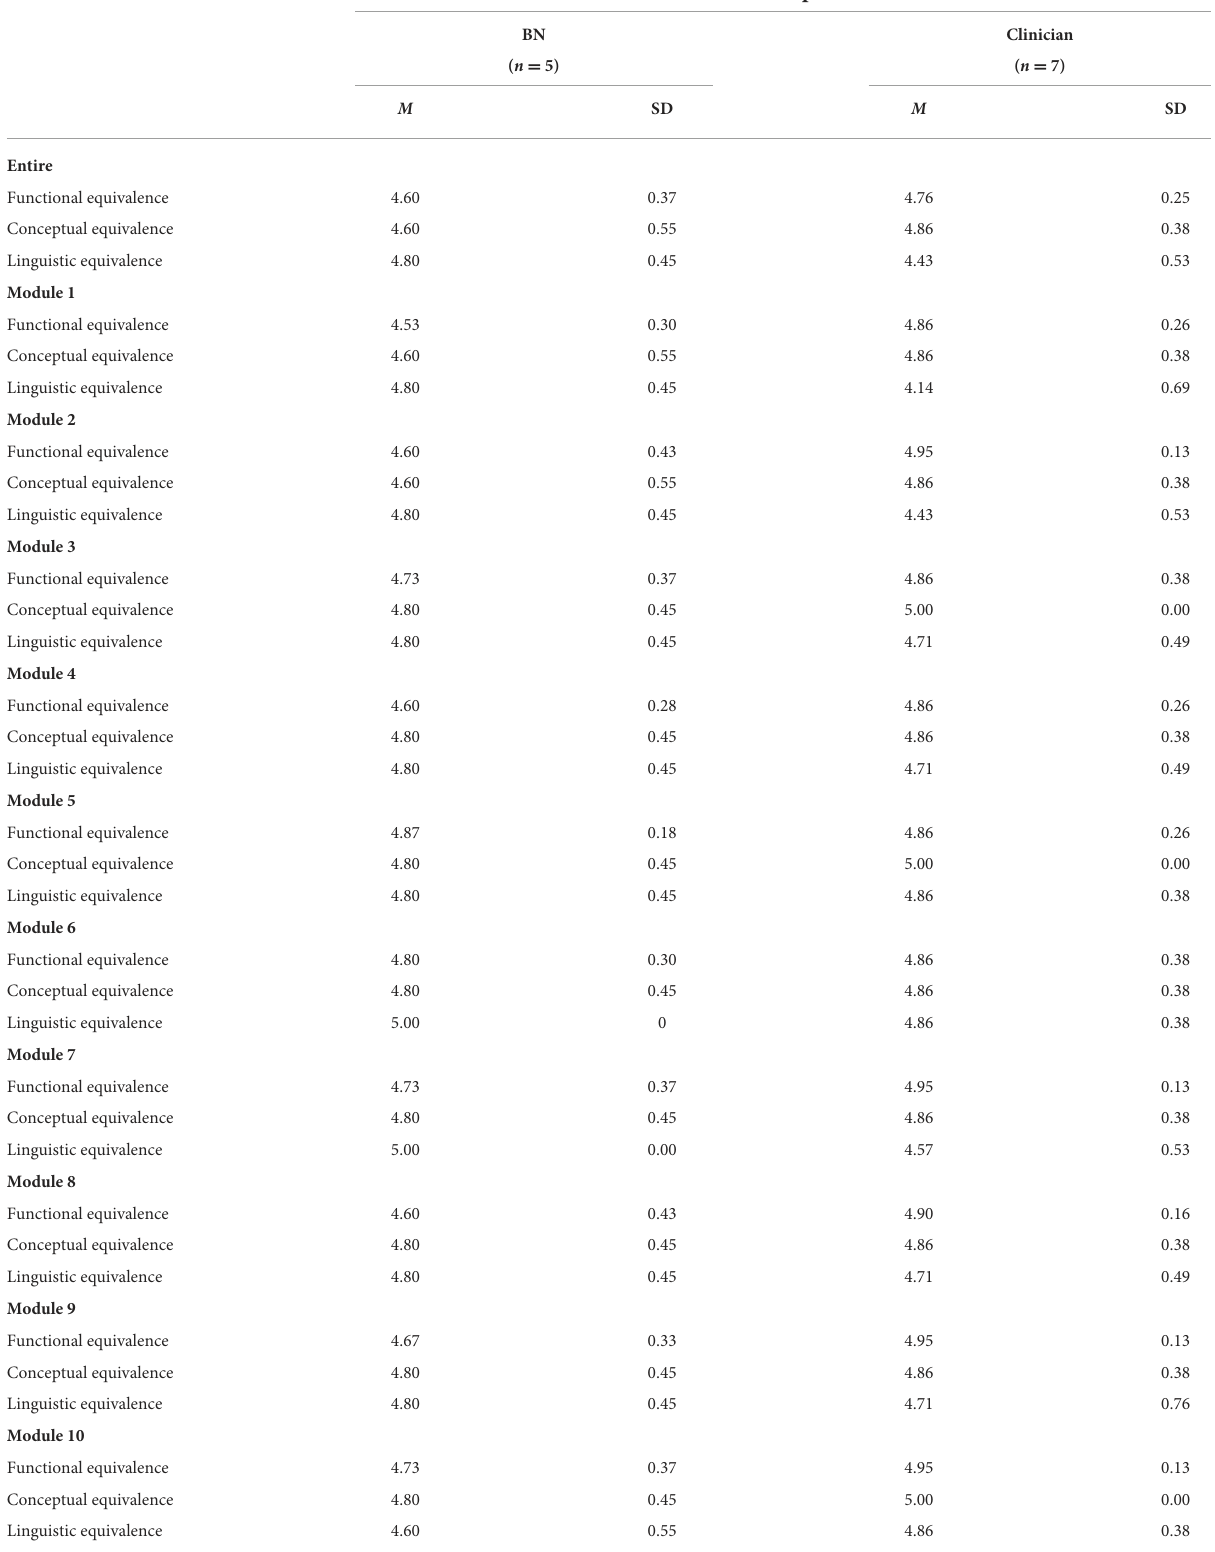
TABLE 2 Results of